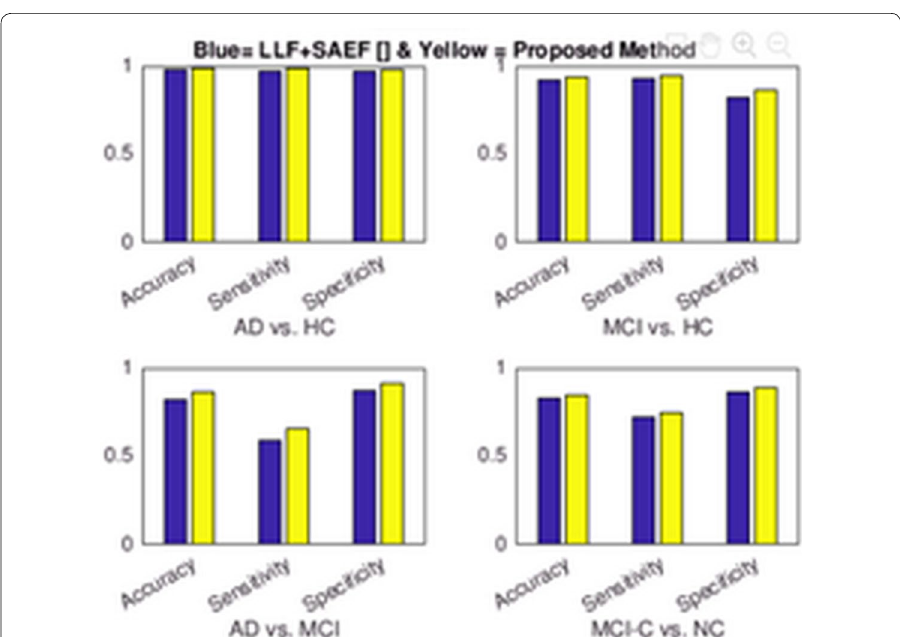
Fig. 6 Comparison of the best performances of the competing